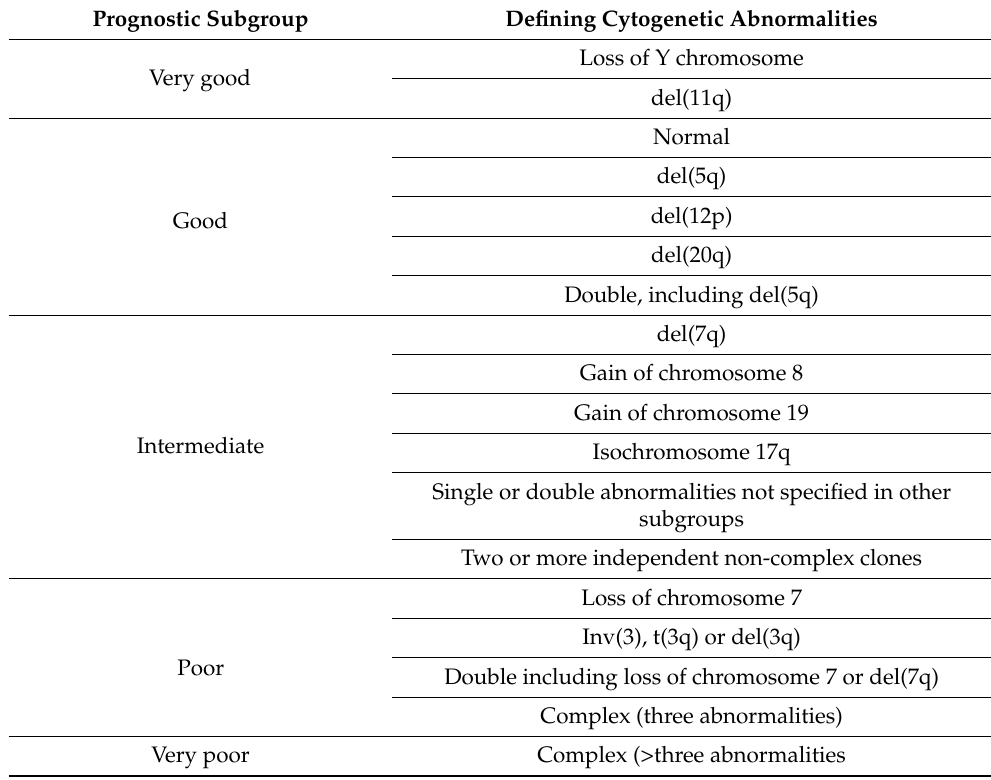
Table 1. The Comprehensive Cytogenetic Scoring System (CCSS) for myelodysplastic syndromes. Adapted from Schanz et al. [22].